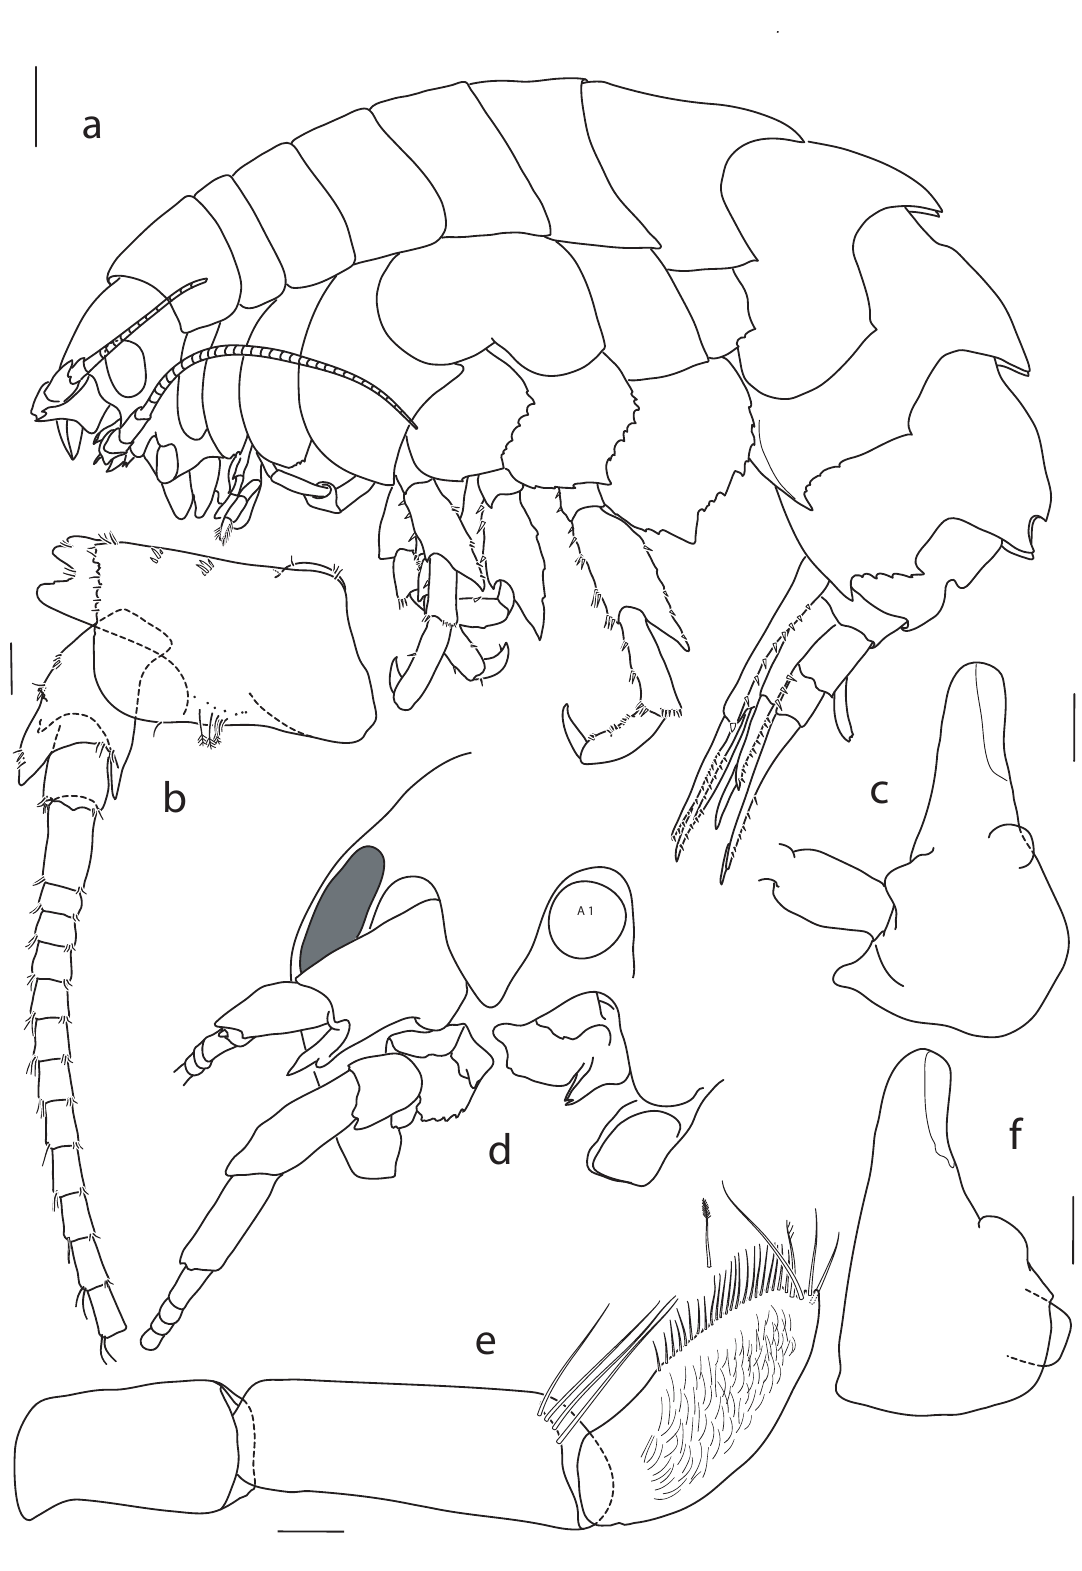
Fig. 18. Labriphimedia vespuccii K.H. Barnard, 1931, ♀, 21 mm (ZMB 34096). a . Habitus, left body side. b . Antenna 1. c . Left mandible. d . Head, frontal aspect. e . Mandible palp. f . Right mandible. Scale bars: a = 1 mm; b–c, f = 200 µm; e = 100